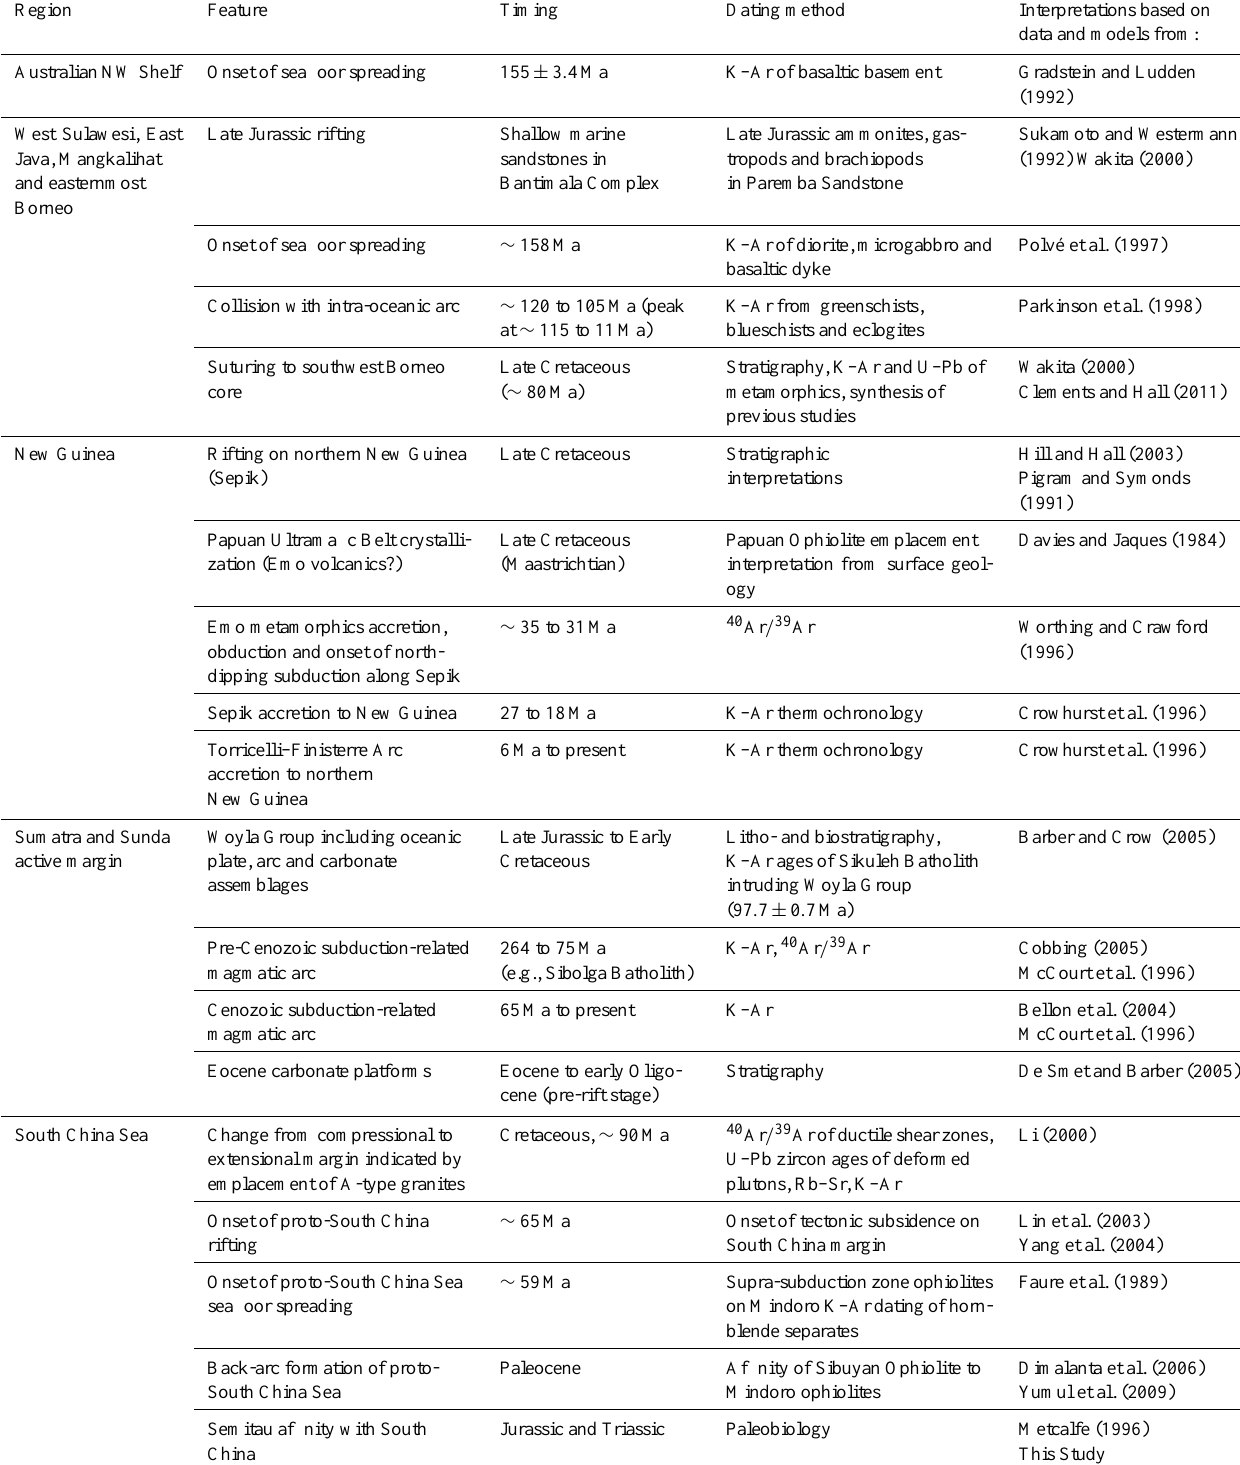
Table 2. Data and interpretations used for constructing plate motion model.